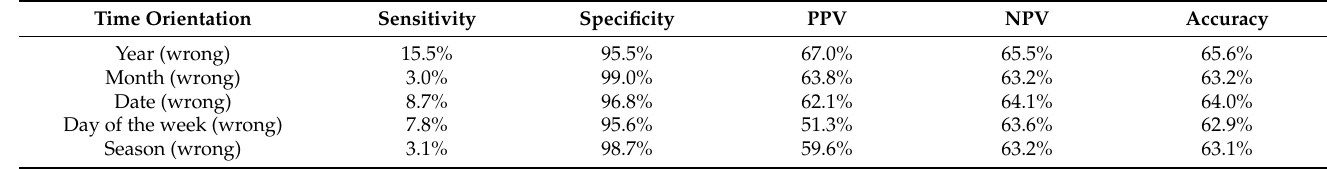
Table 5. Time-orientation tests for the diagnosis of MCI or